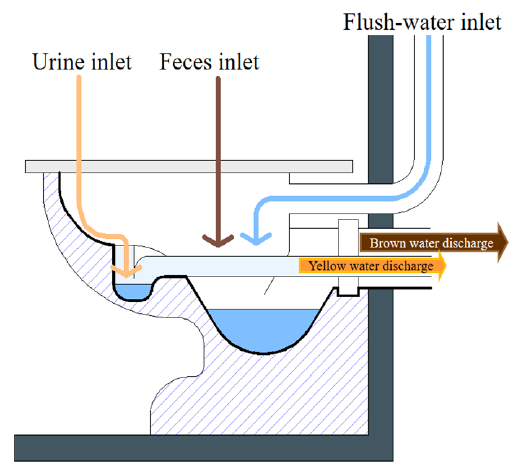
Figure 5. Simple divergent toilet model.